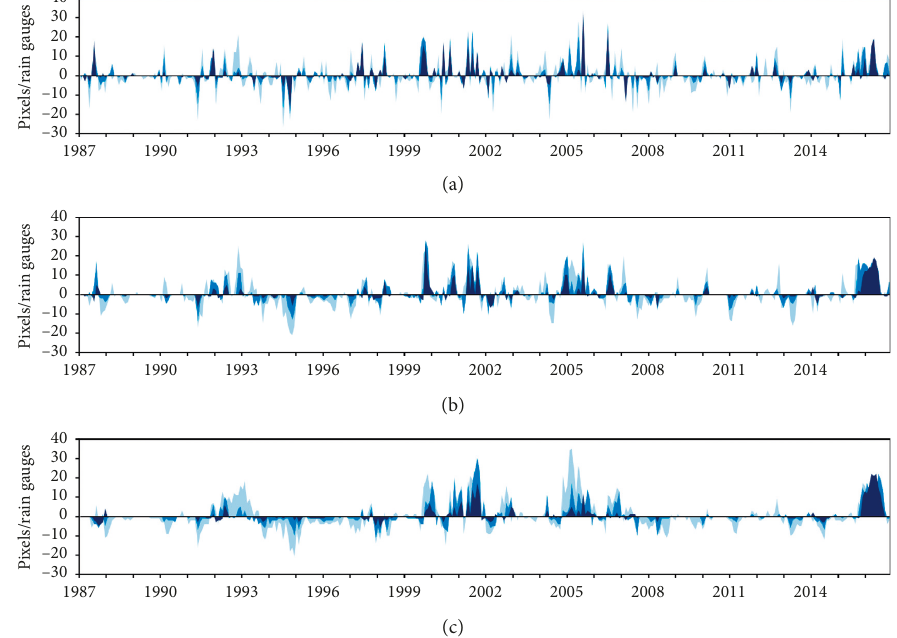
Figure 12: Temporal evolution of the difference between the number of CHIRPS pixels and the number of rain gauges with wet conditions for the different wet categories and timescales: (a) SPI1, (b) SPI3, and (c)